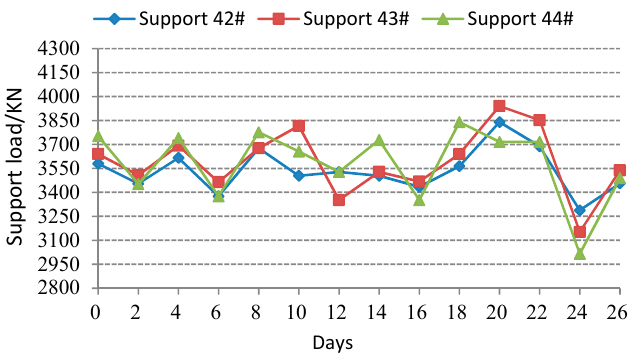
Figure 10. Behavior of the support load in the upper area of the working face.